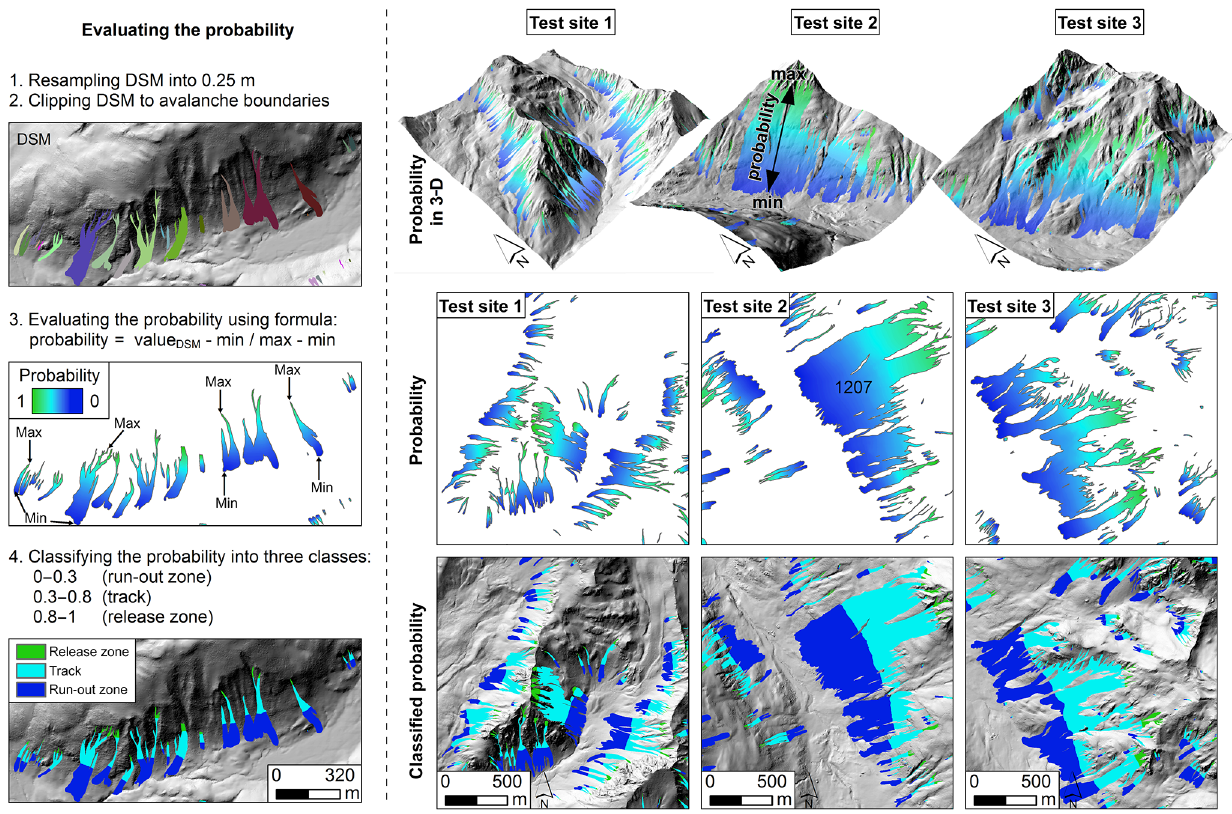
Figure 9. Estimating the probability of an avalanche release area. A probability close to 1 indicates a pixel representing a release zone, whereas a probability close to 0 indicates a run-out zone in automatically classified